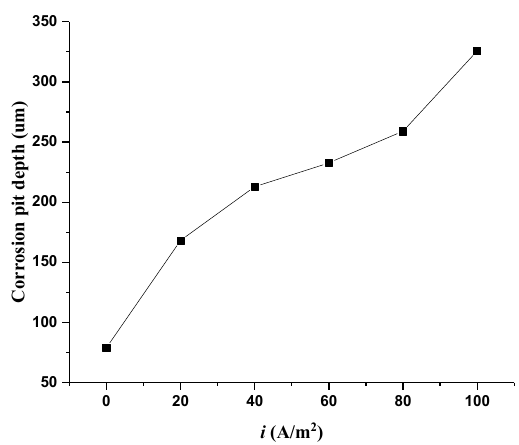
Figure 7. The corrosion pit depth of the 3PE-coated X80 steel samples under DC anode polarization interference with various current densities.